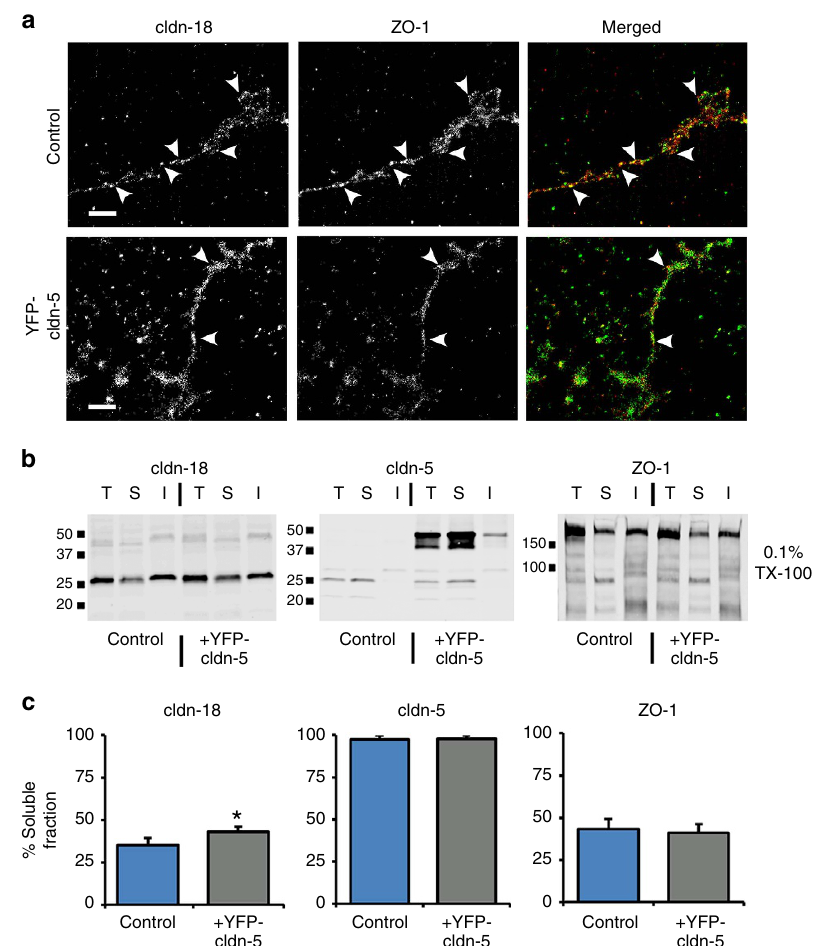
Figure 6 | Claudin-5 expression is sufficient to decrease ZO-1:claudin-18 co-localization and increase claudin-18 solubilization. ( a ) Control or YFP-claudin-5 transduced AECs were cultured for 6 days, immunolabeled and then imaged by STORM for claudin-18 and ZO-1. Increased claudin-5 expression decreased the extent of ZO-1:claudin-18 co-localization (see text). Arrowheads show sites of co-localization. Bar, 1 m m. ( b , c ) Biochemical analysis of protein insolubility was assessed by a Triton X-100 solubilization assay comparing control AECs to YFP-claudin-5 transduced cells. At 6 days in culture, AECs were harvested and extracted using 0.1% Triton X-100, an aliquot of total protein (T) was set aside and the remainder was centrifuged to separate Triton X-100 soluble (S) and insoluble (I) fractions that were measured by immunoblot for claudin-18, claudin-5 and ZO-1. Quantification of the soluble fraction revealed that YFP-claudin-5 expression significantly increased claudin-18 solubility from 35.2 ± 1.8 to 42.1 ± 0.6 ( n ¼ 3, * P ¼ 0.003, unpaired two-tailed t -test) while claudin-5 and ZO-1 solubility did not significantly change. All quantitative data represents average ±